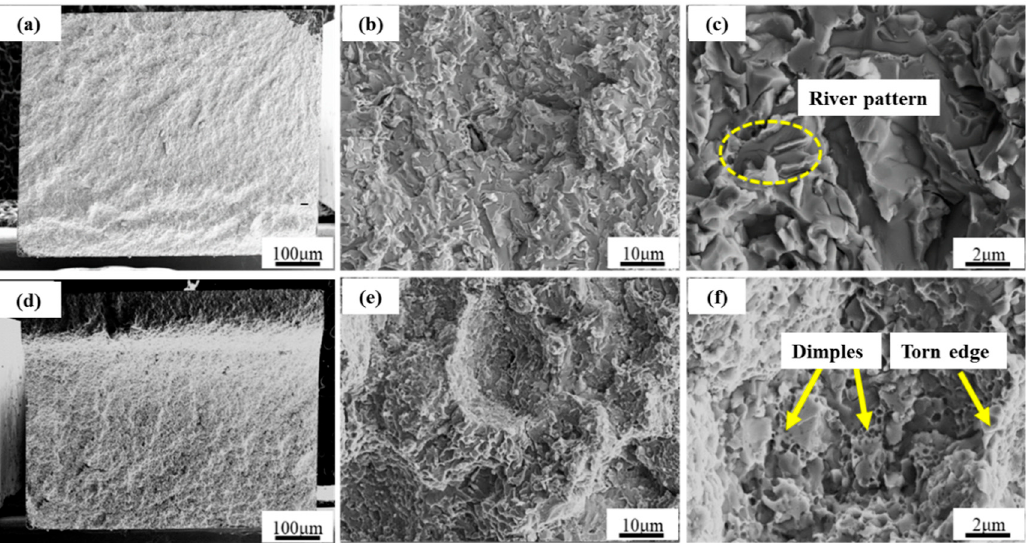
Figure 12. Bending fracture of the Co-Cr-W alloy and composite materials. ( a – c ) The Co–Cr–W alloy; ( d – f ) the Co–Cr–W matrix composites.